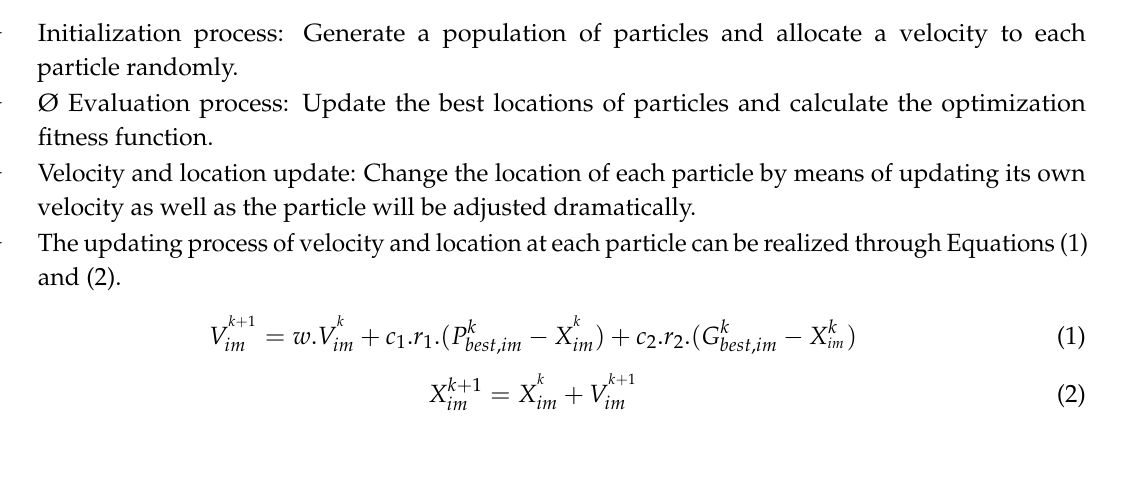
Figure 4. Procedures of the Particle Swarm Optimization [24].